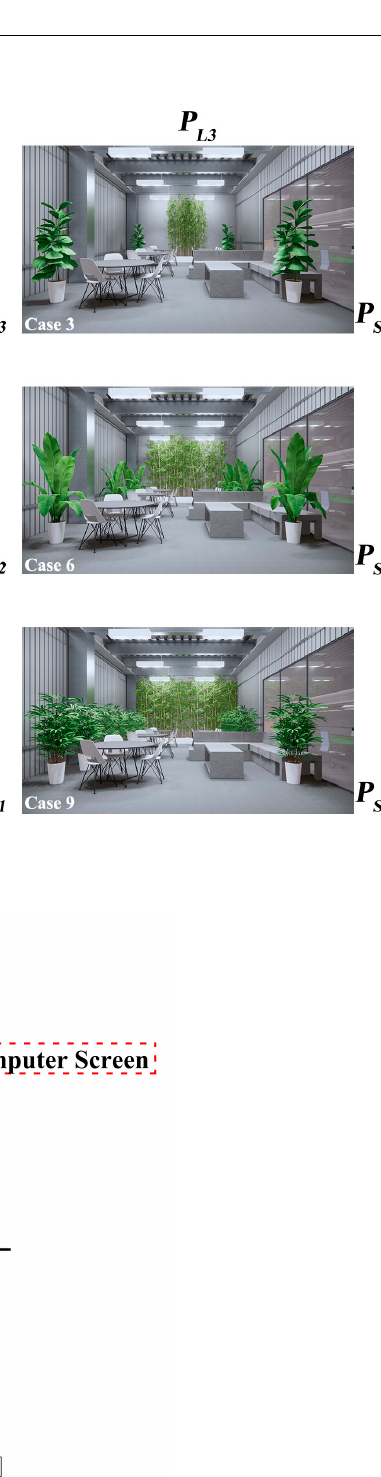
7 of 21 Table 2. L9 (3 * 4) orthogonal table of experimental design. Cases